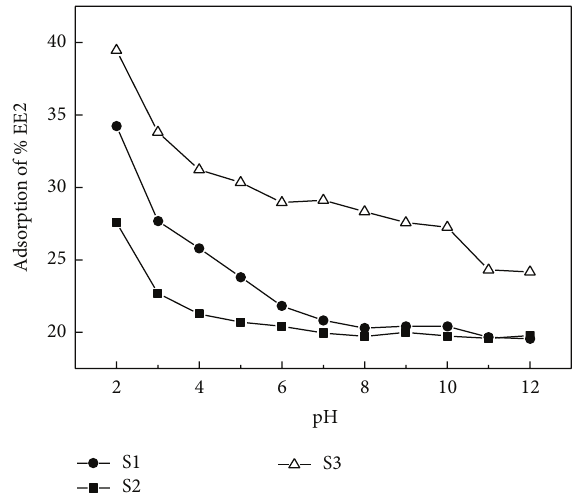
Figure 3: Effects of pH on the EE2 adsorption.